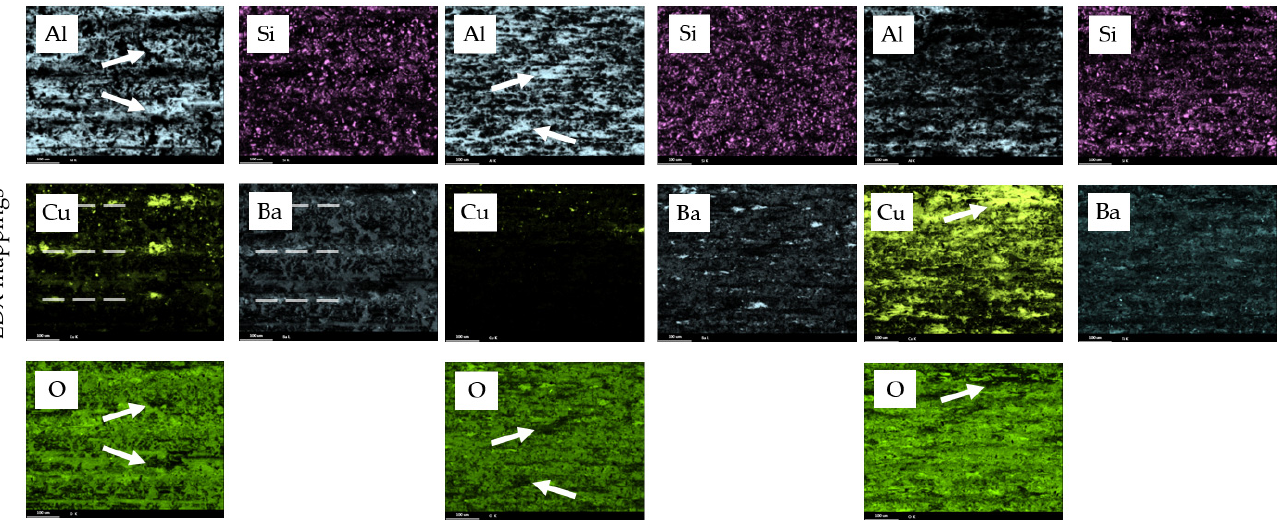
Figure 8. Typical SE images taken from wear tracks of surface R ( left ), F ( middle ), and E ( right ) after medium distance under HP . It can be seen that tribosurface builds up in different ways (compare EDX mappings in the second row).